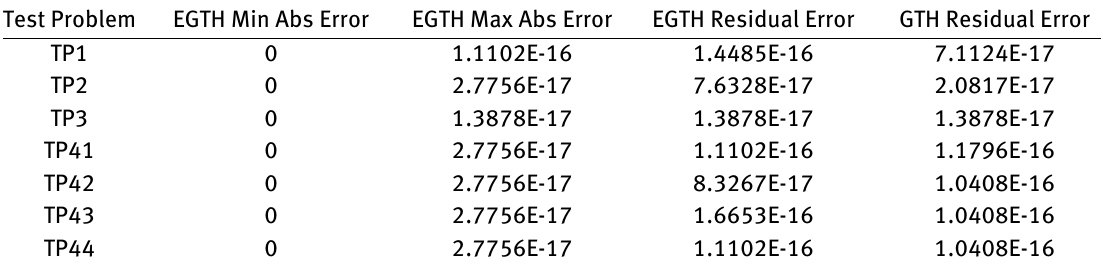
Table 4: Errors for the Stationary distributions under double precision.